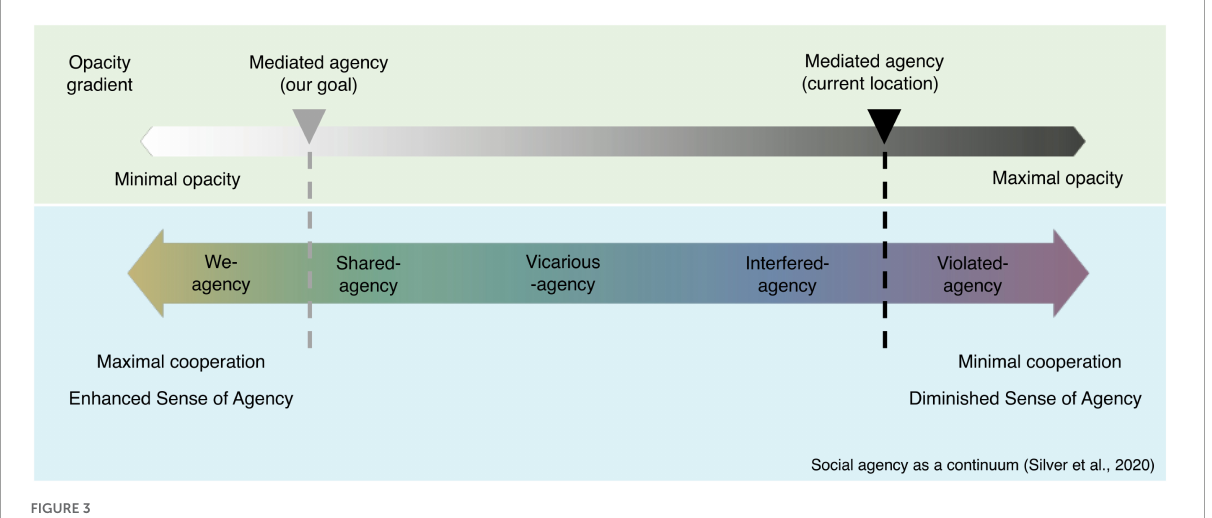
FIGURE3 Location of the experience of mediated agency on the social agency continuum. Reproduced from Silver et al. (2020), with permission from